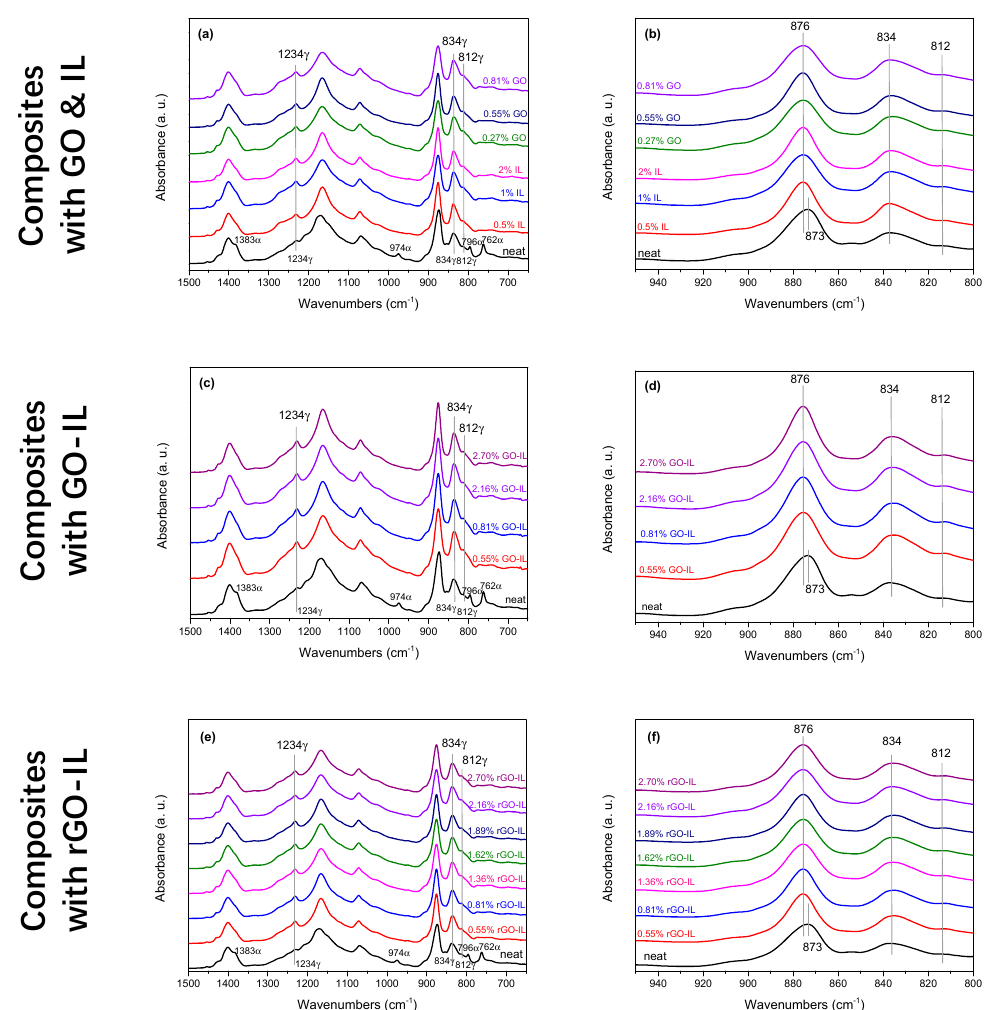
Figure 12. ATR FTIR spectra of neat P(VDF-CTFE) and composites with IL, GO ( a , b ); GO-IL ( c , d ); and rGO-IL ( e , f ).